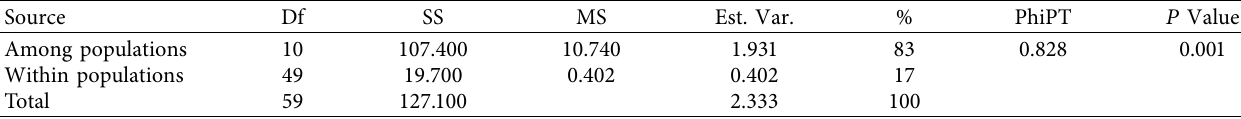
SS: sum of squares, MS: mean square, Est. Var: estimated